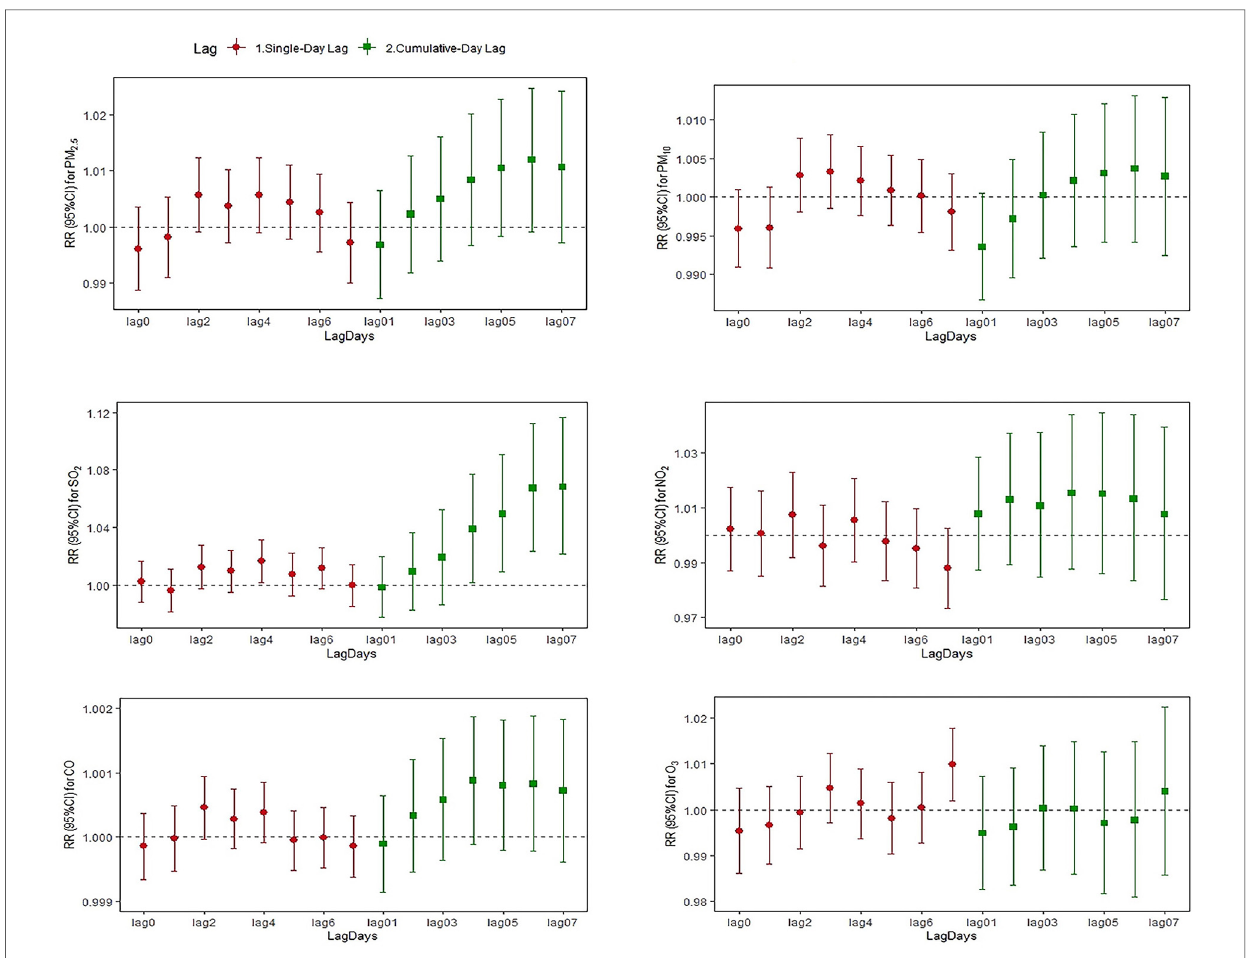
FIGURE 2 Relative risk and 95% CI of hospital admissions for mental and behavioral disorders at different lag days for every 10 µg/m 3 increase in pollutant